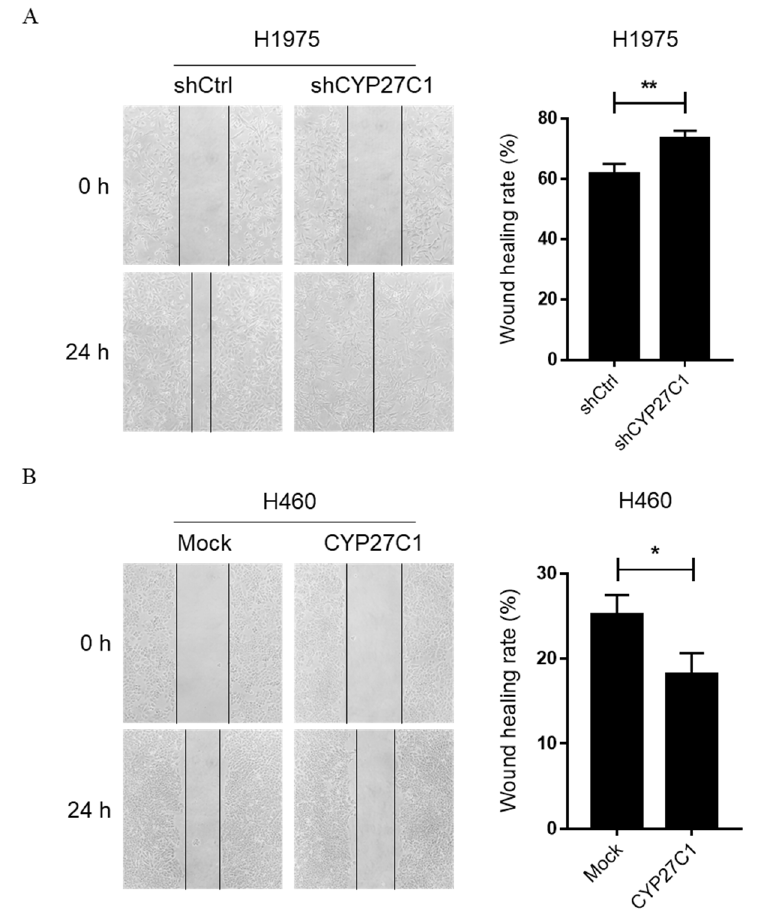
Figure 6. CYP27C1 expression affects ability of migration in lung cancer cells. ( A , B ) H1975- shCYP27C1, H460-CYP27C1, and the corresponding control cells were seeded in 12-well plates for 24 h before cell scratch assay. The wound areas were captured at different time points (0 h and 24 h). Scratching wound healing rate was analyzed by ImageJ software. Results were analyzed by unpaired two-tailed T test. *, p < 0.05, **, p < 0.01.